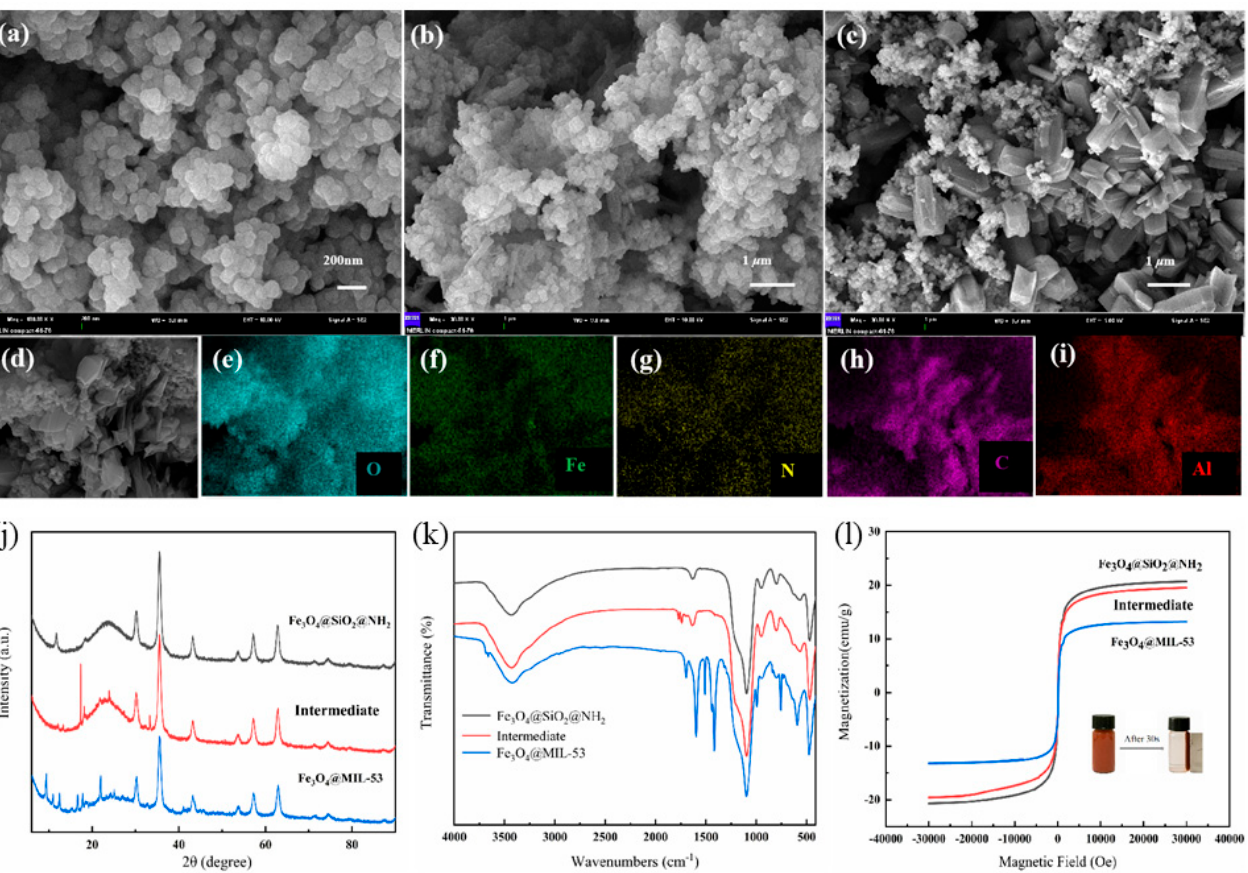
Figure 2. SEM images of amino modified Fe 3 O 4 magnetic material ( a ), H 2 BDC modified Fe 3 O 4 mag- netic material ( b ), andFe 3 O 4 @MIL-53(Al) ( c – i ) SEM-mapping of Fe 3 O 4 @MIL-53(Al). XRD patterns ( j ), FT-IR spectra ( k ), and magnetic hysteresis curves hysteresis ( l ) of magnetic materials.